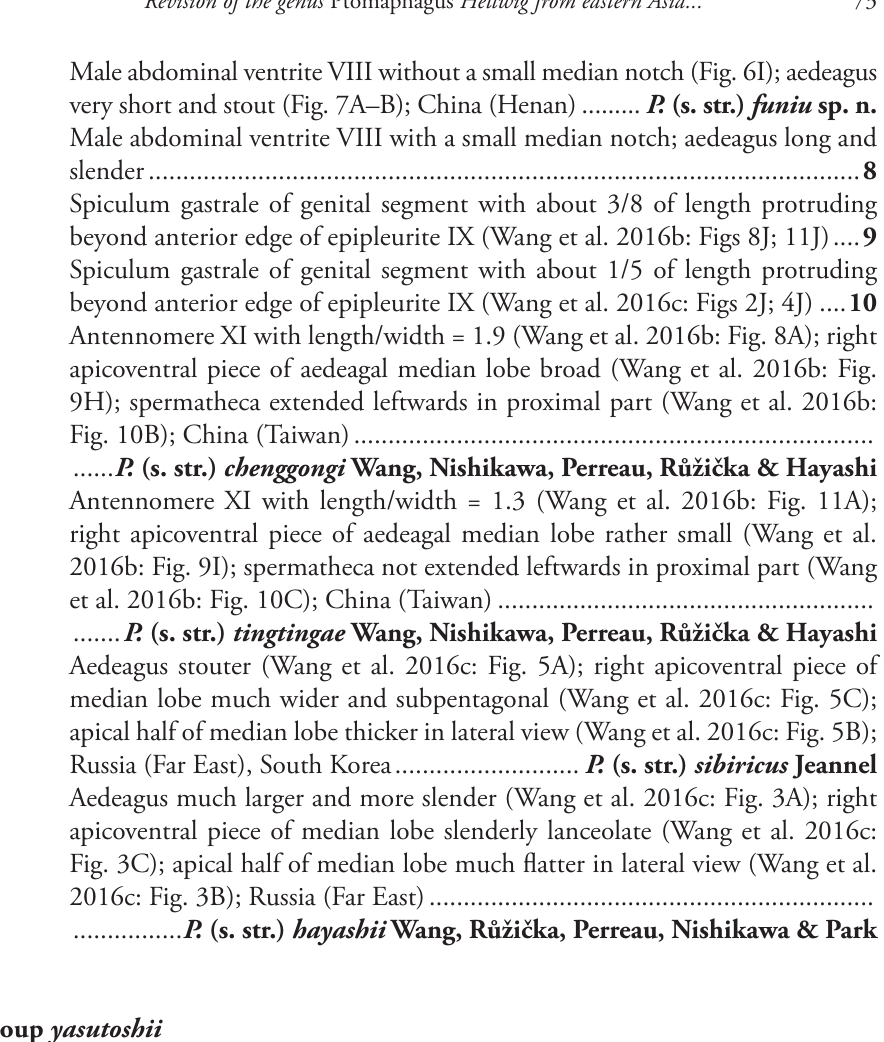
Group yasutoshii Diagnosis. This group is characterised by the following combination of characters: (1) body length ≥ 4.3 mm; (2) antennomere III much longer than II; VI subquadrate, length/width = 0.8; (3) metathoracic wings absent; (4) aedeagus with median lobe turning to right at apex; (5) spermatheca discoid in distal part. Species included: P. (s. str.) yasutoshii Nishikawa, 1993 (China (Taiwan)) = P. (s. str.) smetanai Perreau, 1996